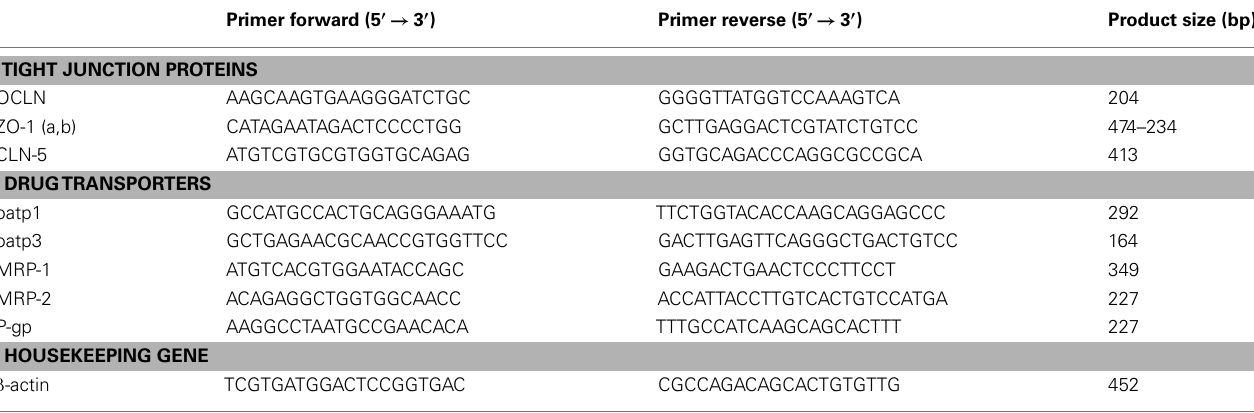
Table 2 | Primers used in RT-PCR